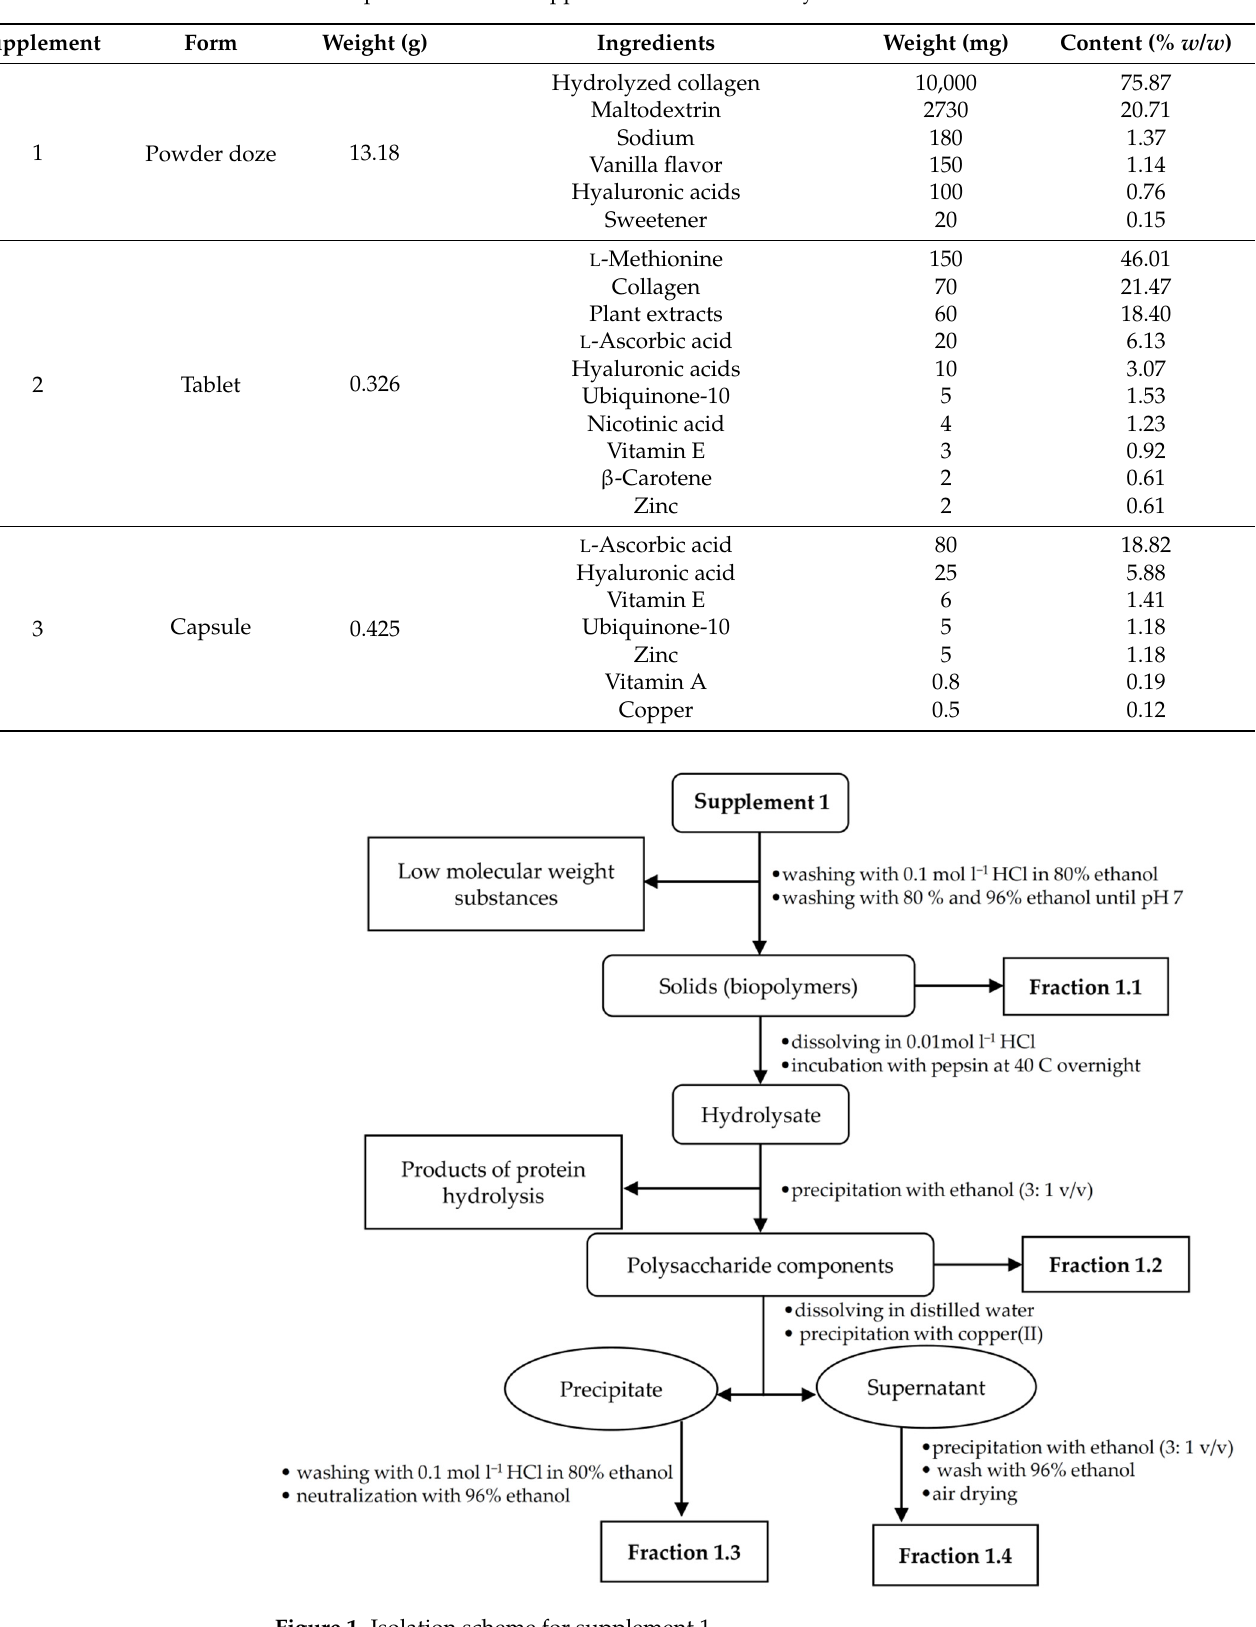
Figure 1. Isolation scheme for supplement 1